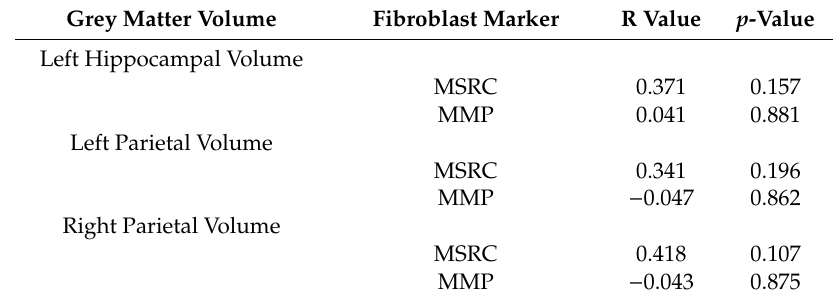
Table 4. Grey Matter Volume Fibroblast metabolic correlations: No significant correlations were seen between MMP nor MSRC and any grey matter volume when controlling for age, length of disease or brain